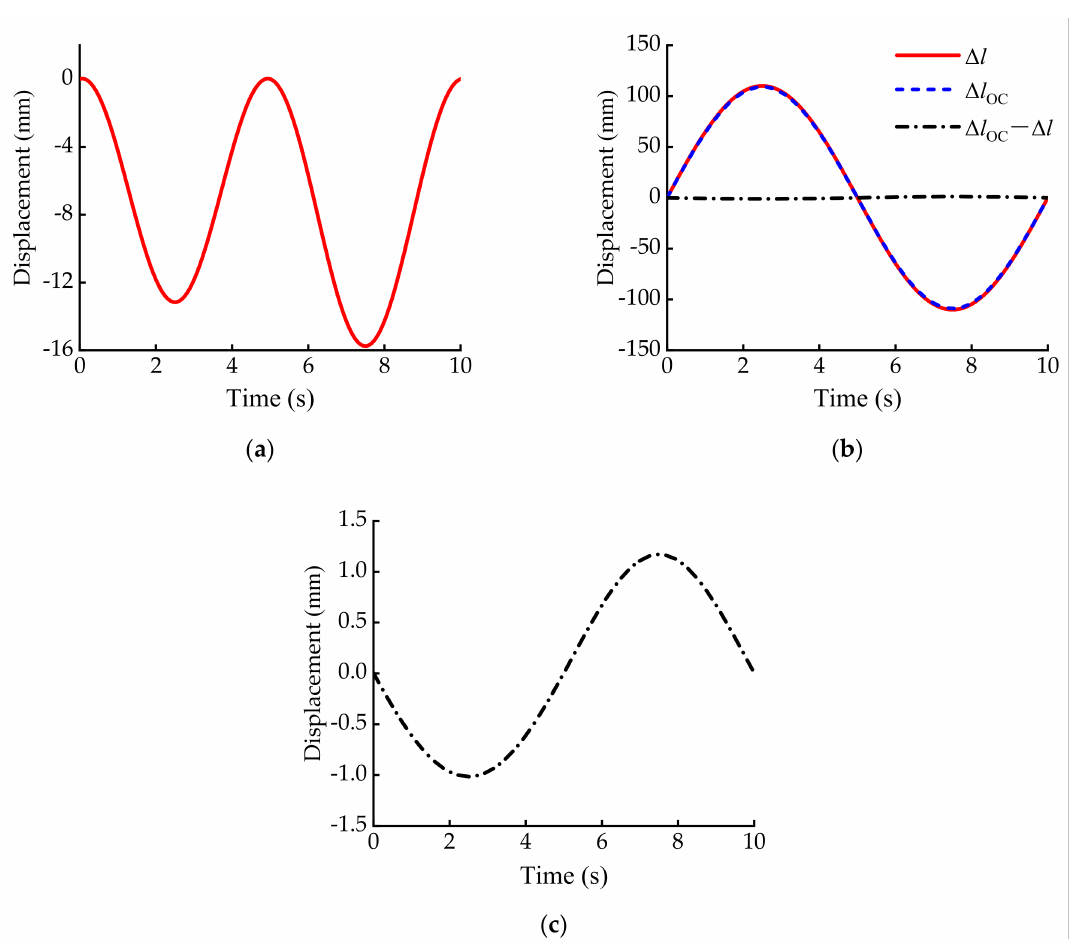
Figure 8. The curve of suspension geometric parameters with time: ( a ) the curve of ∆ y with time t ; ( b ) the comparative curve of ∆ l , ∆ l OC and ( ∆ l OC – ∆ l ) with time t ; ( c ) the enlarged curve of the ( ∆ l OC – ∆ l